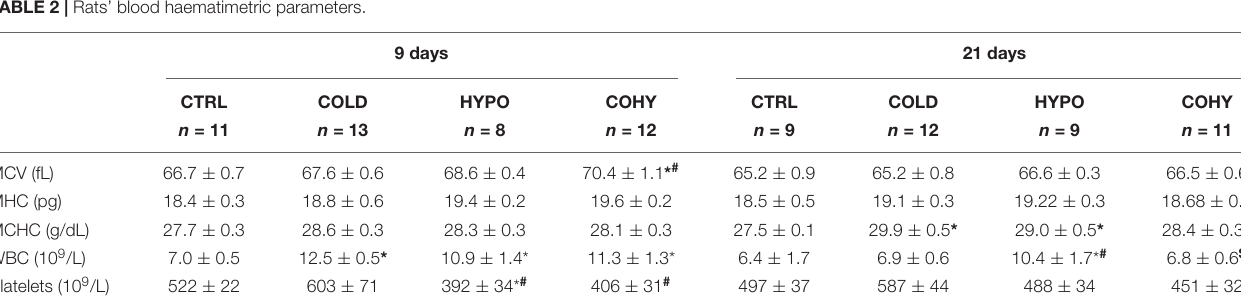
TABLE 2 | Rats’ blood haematimetric